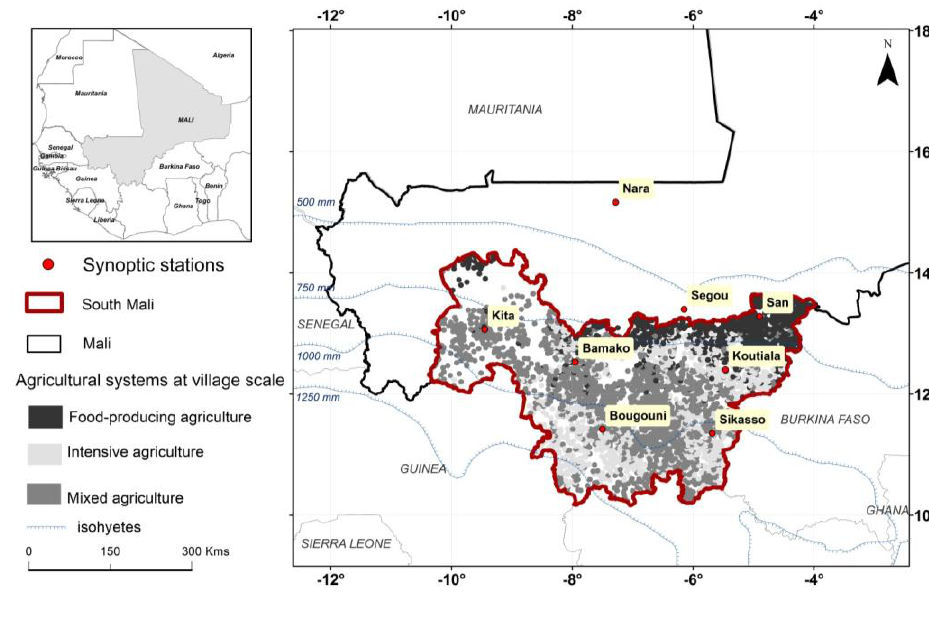
Figure 1. The synoptic station locations and a map of the crop production systems in South Mali